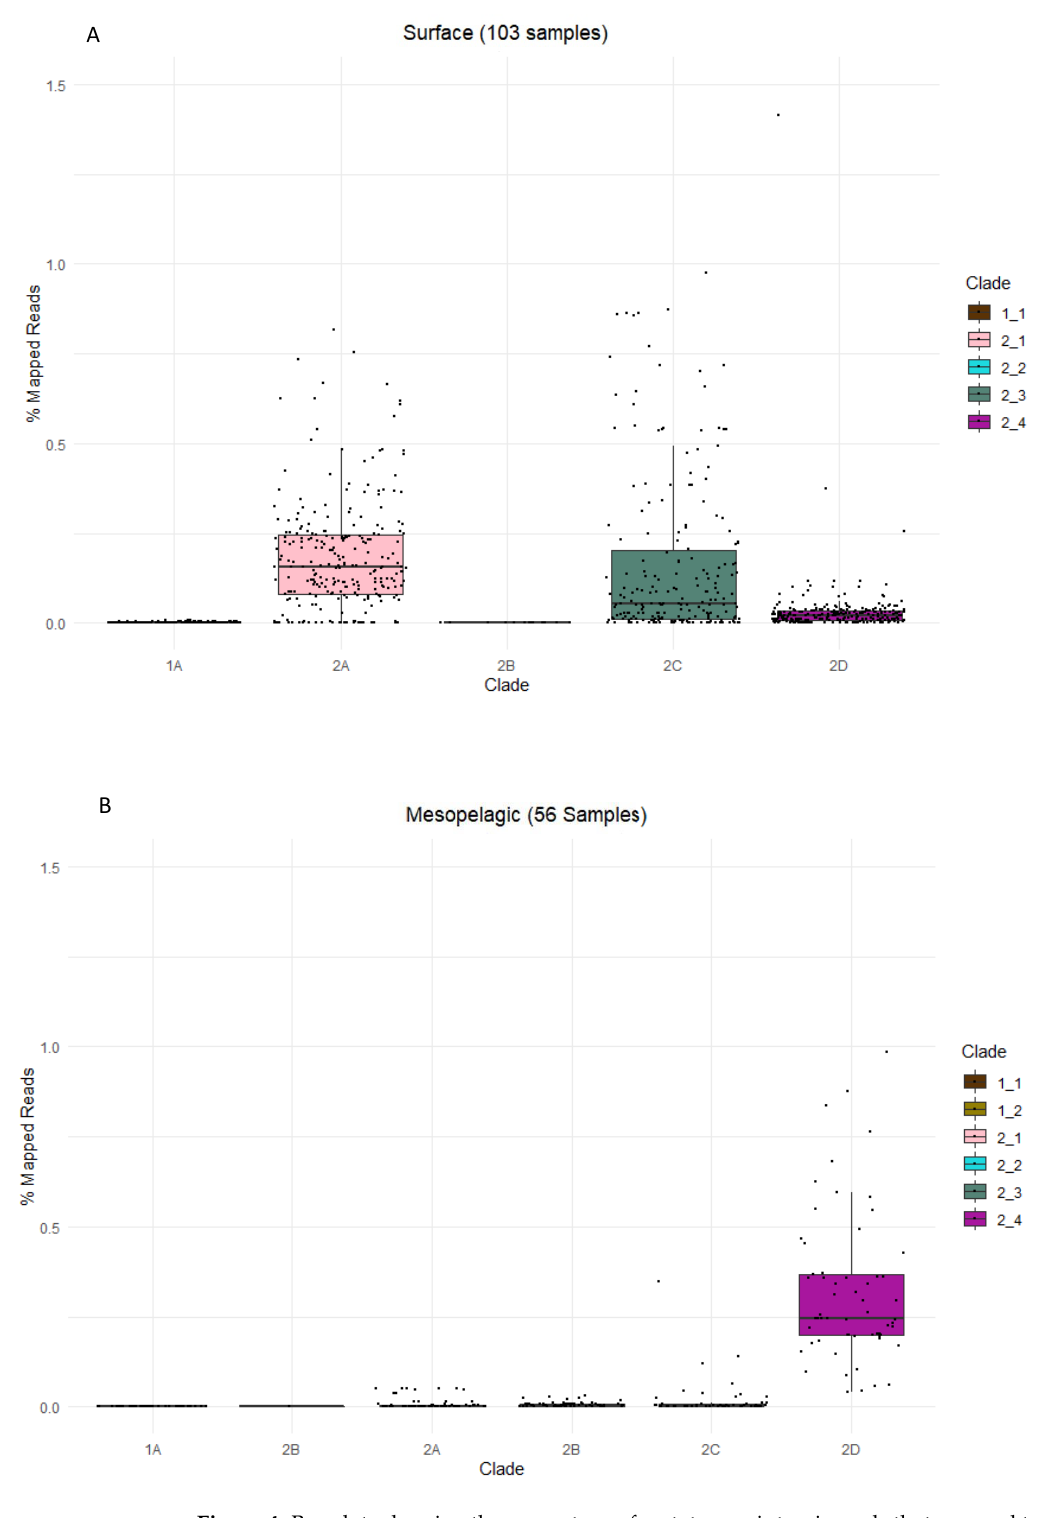
Figure 4. Bar plots showing the percentage of metatranscriptomic reads that mapped to the respective SAR324 clades relative to the total number of reads present in each sample on the x -axis for Surface ( A ) and Mesopelagic ( B ). The largest number of SAR324 mapped reads in the surface layer belong to clades 2A and 2C, while 2D appears to be the dominant clade in the mesopelagic